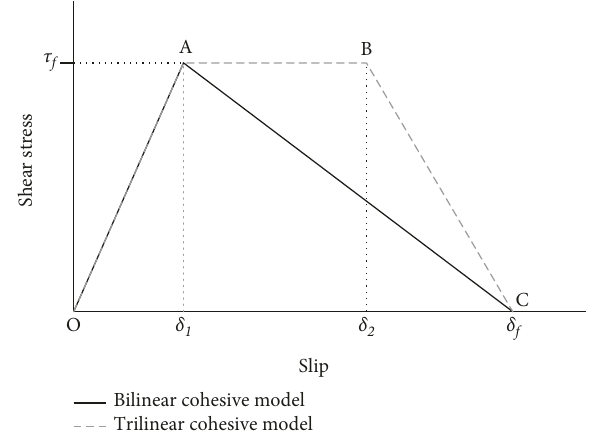
Figure 3: Schematics for bilinear and trapezoidal traction-sepa- ration (bond-slip) models implemented in